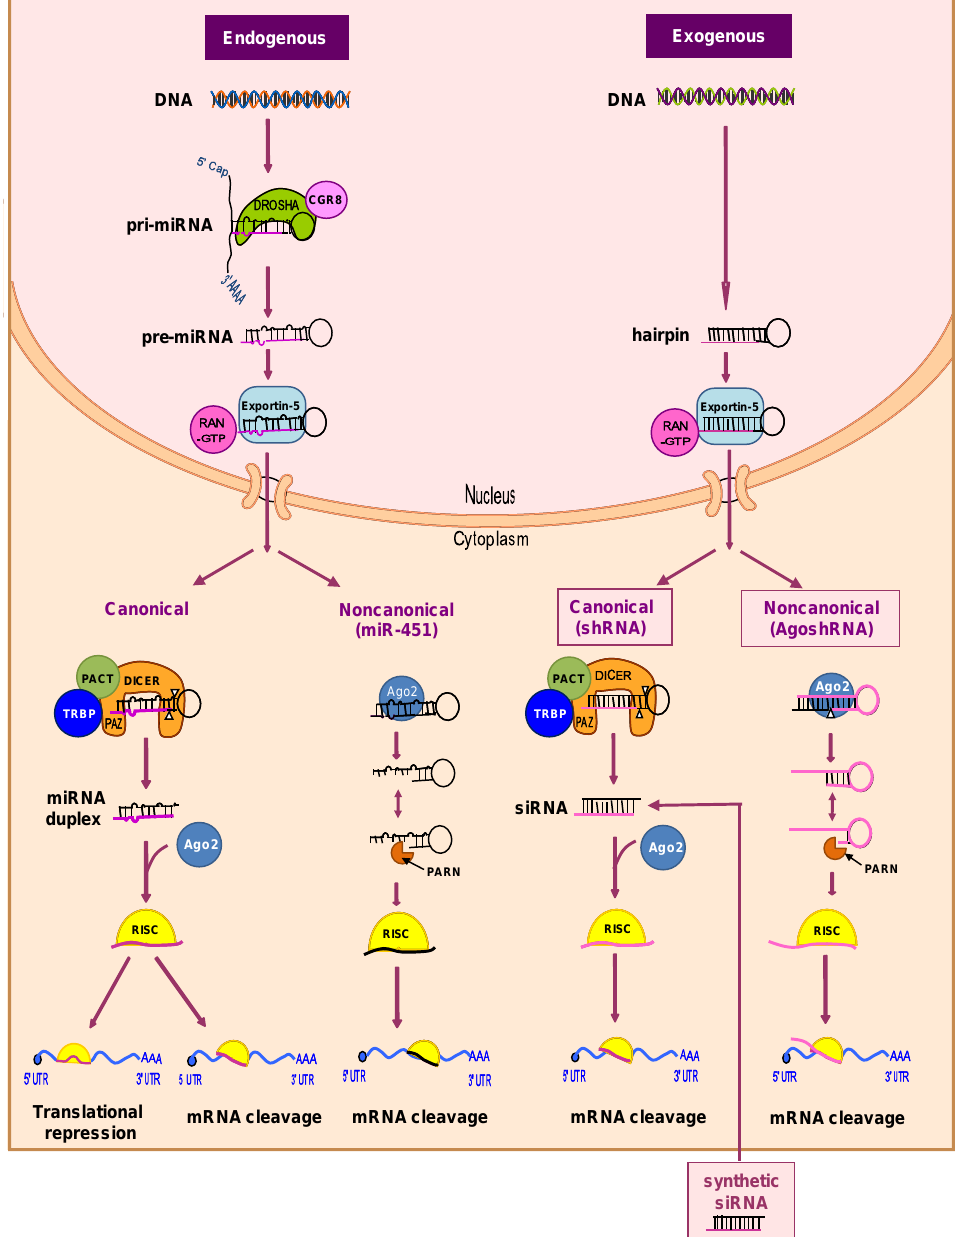
Figure 3. The endogenous miRNA and exogenous shRNA processing pathways. The intracellular processing pathways are depicted starting from the miRNA gene of the cell (endogenous) or the transduced shRNA gene cassette (exogenous). The canonical Dicer-dependent and noncanonical Dicer-independent pathways are depicted for both molecules. Ago2 plays an essential role in Dicer-independent pathways. See the text for further details. PACT: Protein activator of protein kinase R; Pri-miRNA: Primary miRNA; Ago2: Argonaute 2 nuclease; RISC: RNA-induced silencing complex; TRBP: Transactivation response RNA-binding protein.